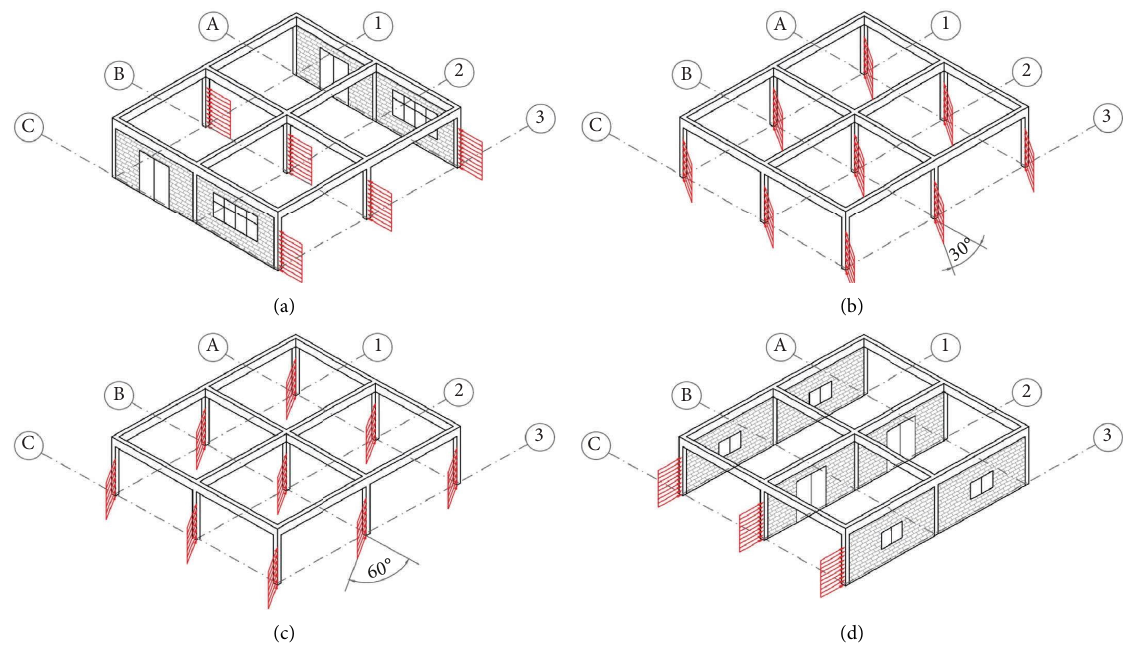
Figure 8: Applied tsunami forces acting on the building columns in each fow direction. (a) 0 ° . (b) 30 ° . (c) 60 ° . (d) 90 °